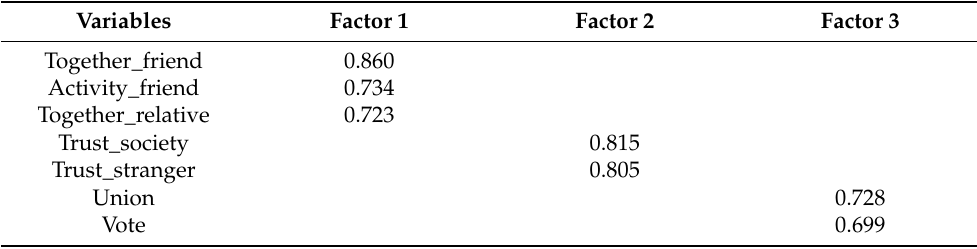
Table A5. Rotated Factor Matrix